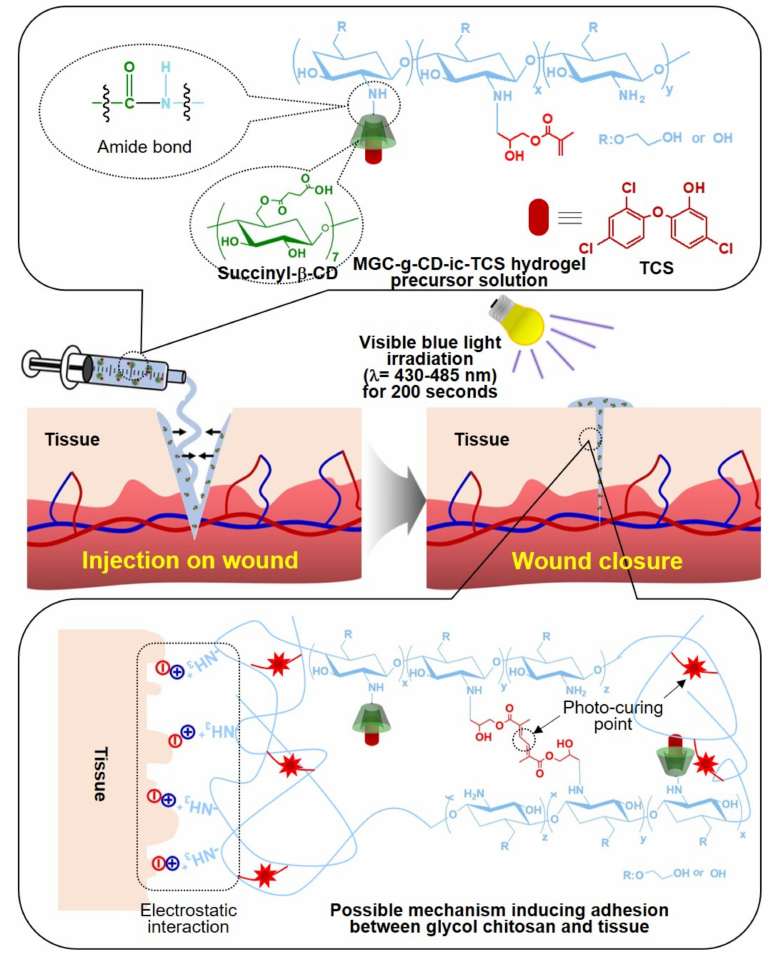
Figure 1. Schematic illustration on the application of β -cyclodextrin/triclosan complex-grafted methacrylated glycol chitosan (MGC-g-CD-ic-TCS) as a tissue bio-adhesive and possible mechanism of adhesion between MGC-g-CD-ic-TCS and soft